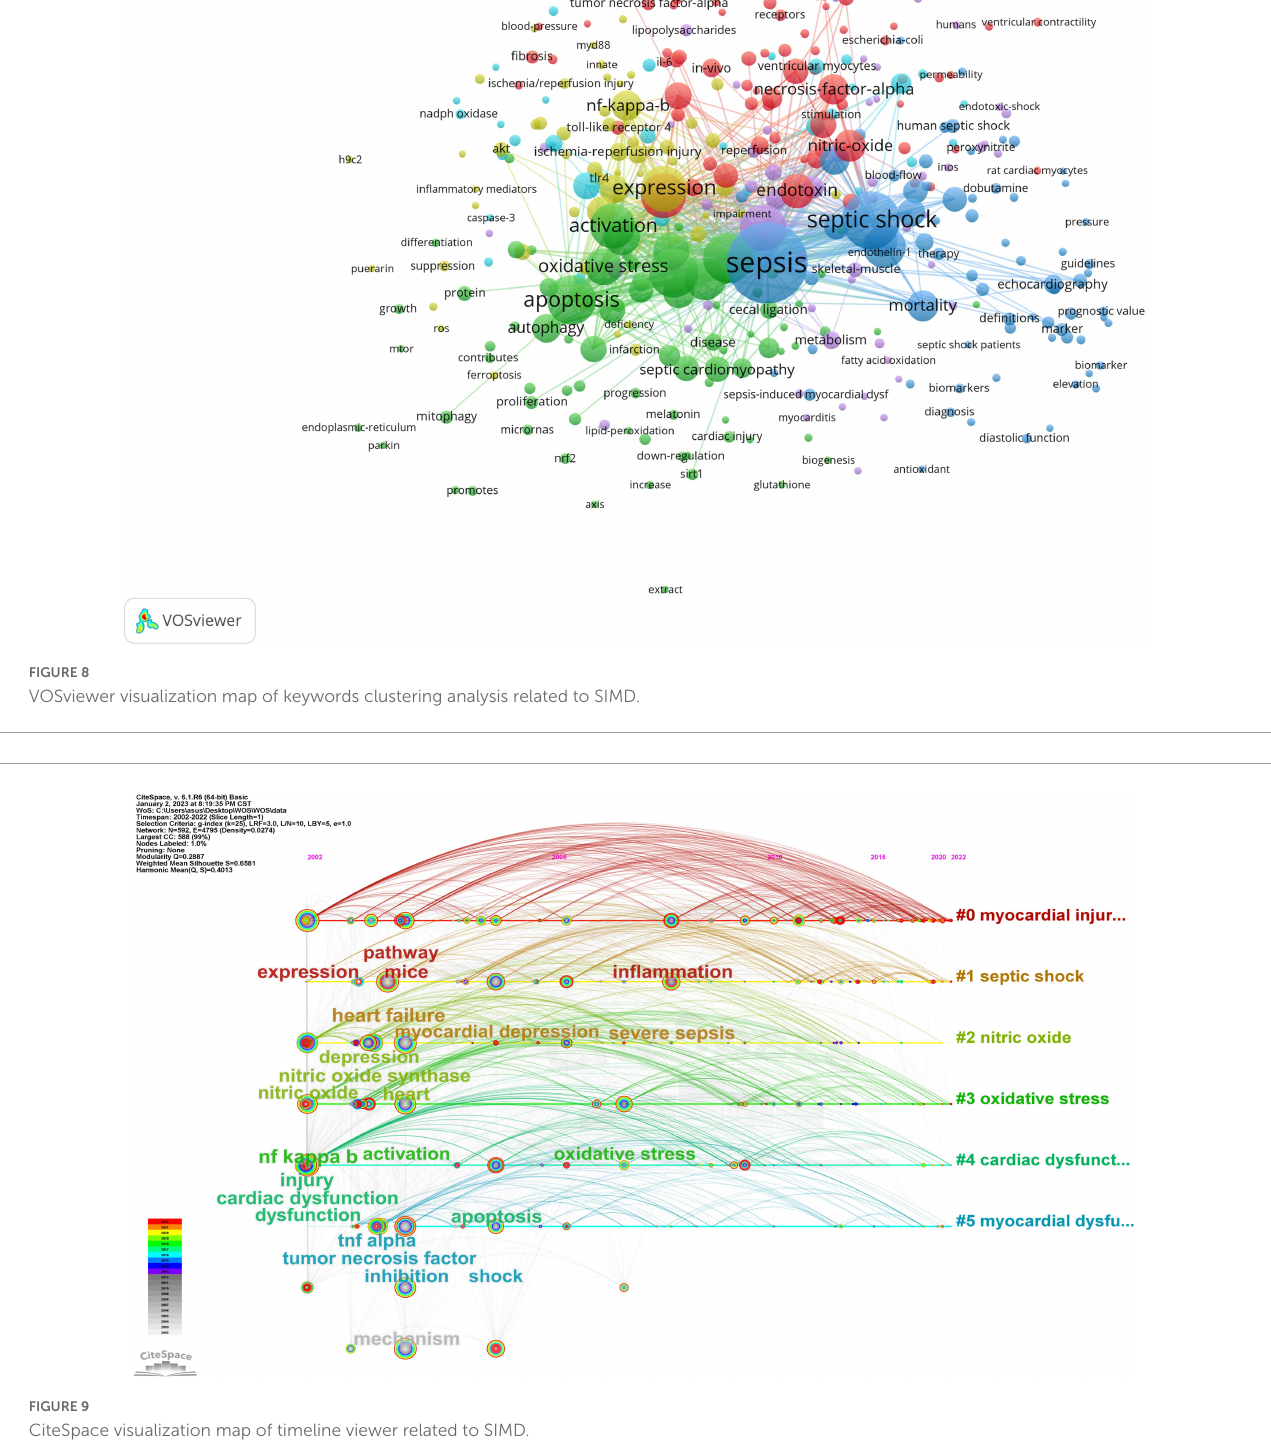
China, but Wuhan Univ, which ranked the 1st, only published 37 articles (3.44%) with a centrality of 0.02. Meanwhile, China Med Univ (25, 2.32%) and Nanjing Med Univ (23, 2.14%) reached the highest centrality of 0.12. This information was consistent with the node diagram in Figure 4 , showing that most institutions had no strong and tight cooperative relationships with